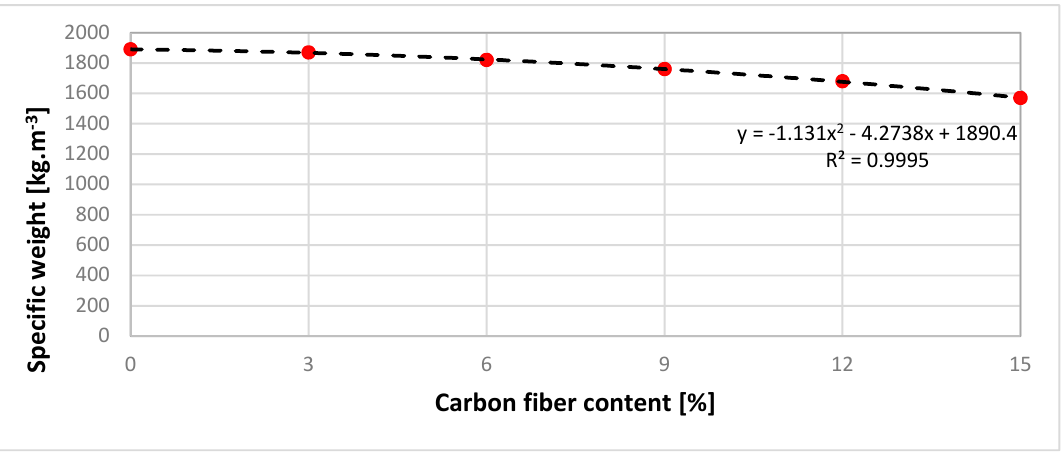
Figure 12. The graphical comparison of the effect of the carbon fiber content on specific weight.